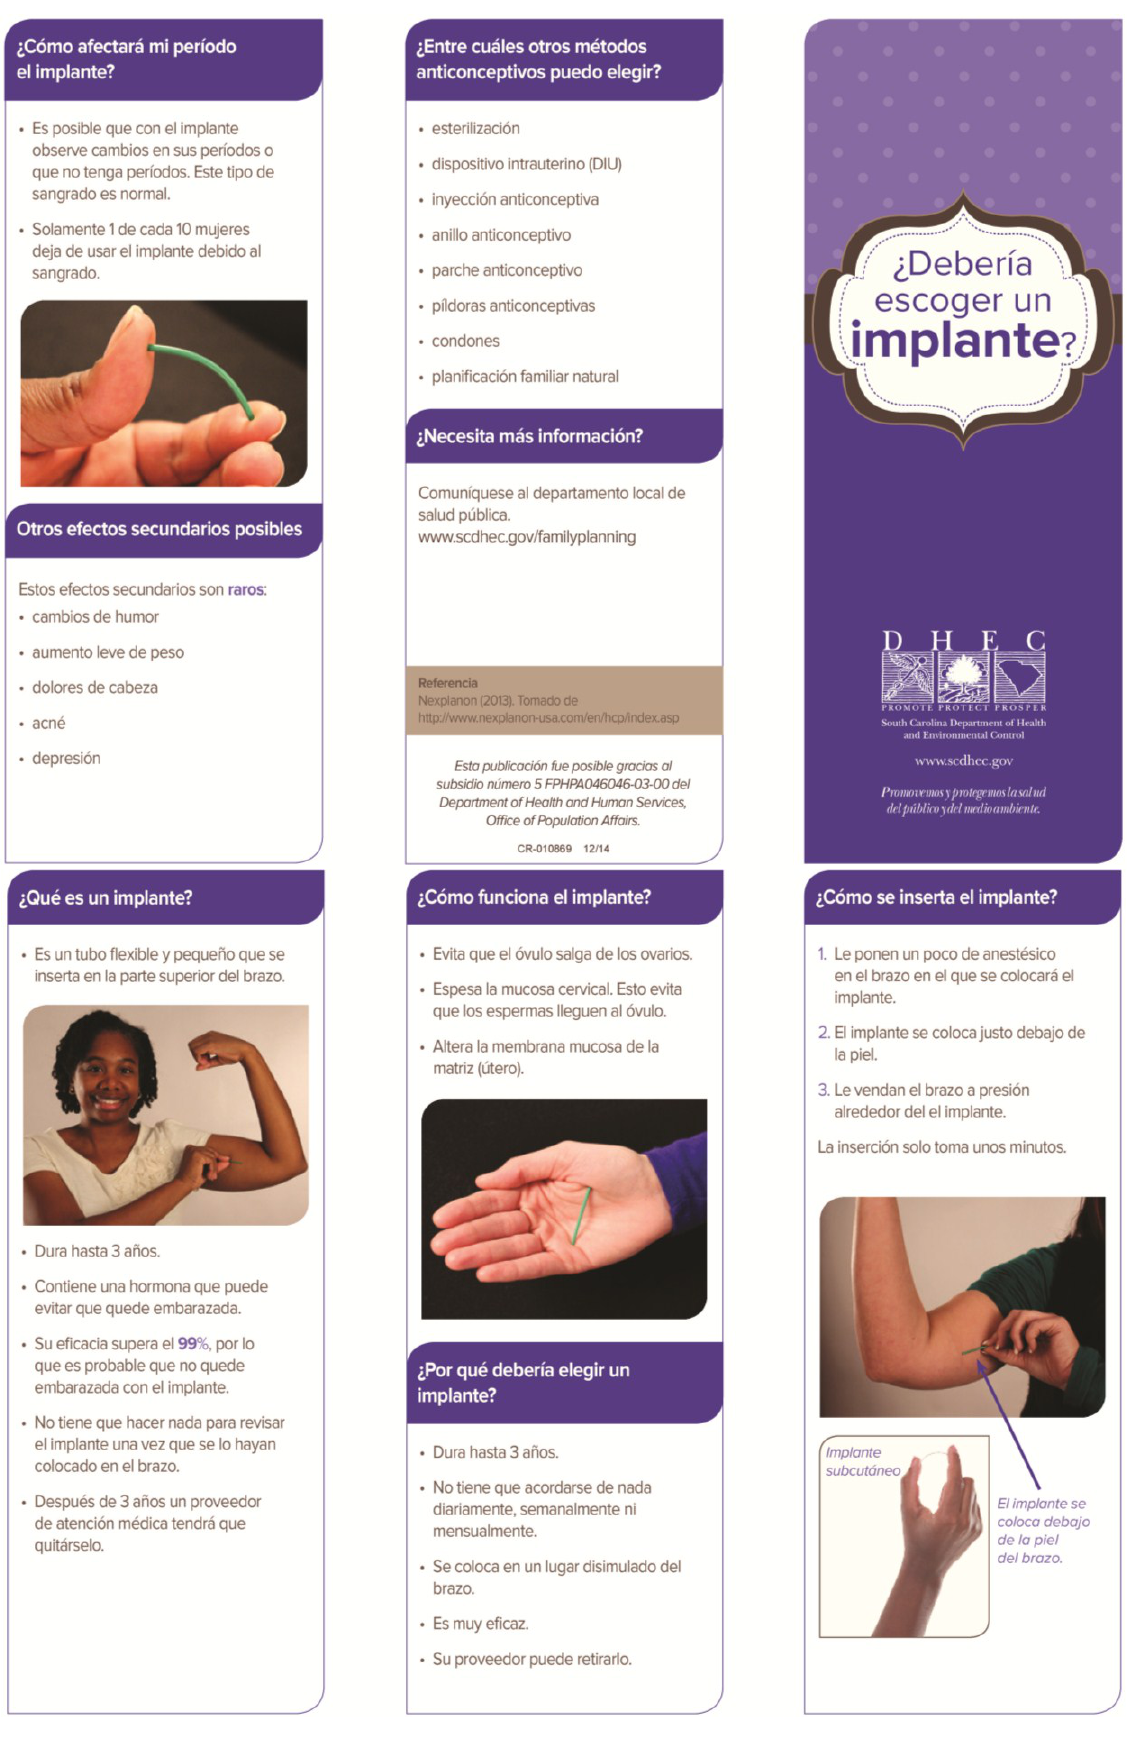
Figure 3. Shared Decision Aid, Spanish Language: “¿Debería escoger un implante?”